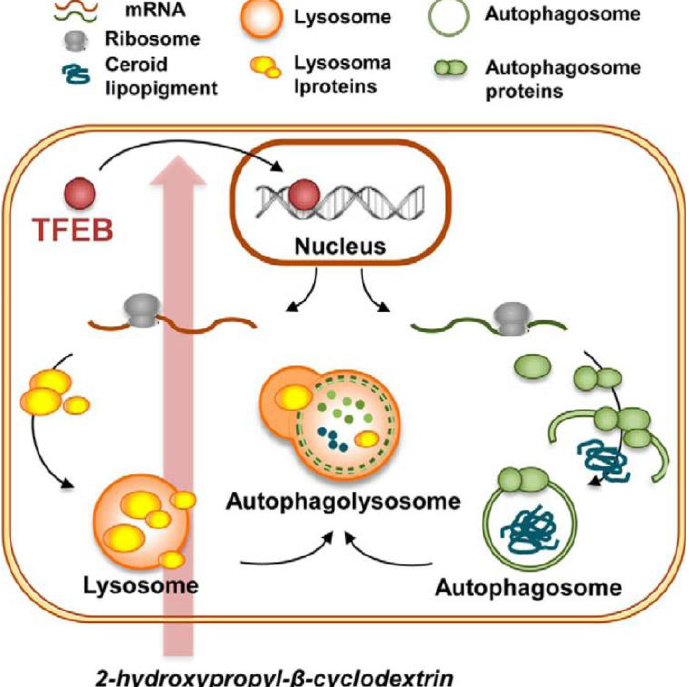
Figure 3. Schematic representation of the proposed adaptive cellular response to HPβCD treatment. HPβCD administration increases expression of the transcription factor EB (TFEB) in the cytoplasmatic ribosomes. Upon translocation from the cytoplasm to the nucleus, TFEB